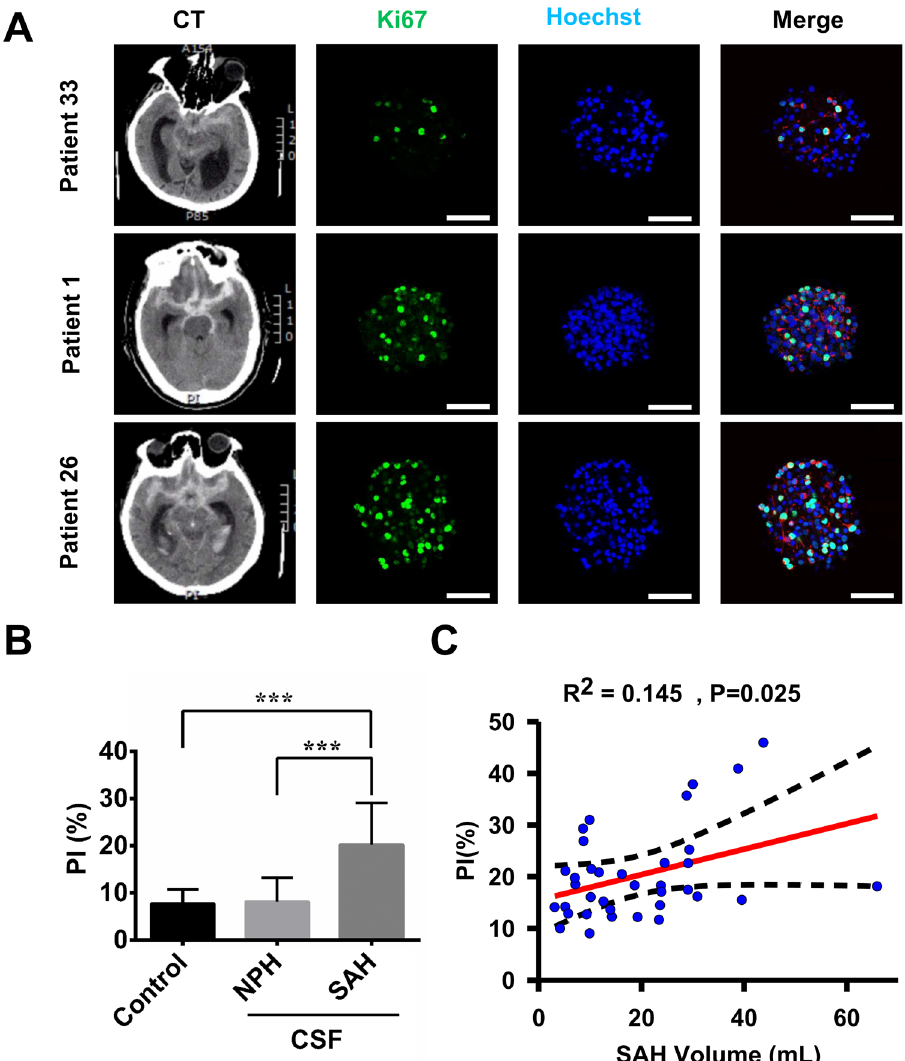
Figure 3. The effects of CSF samples collected at post-SAH day 5 on NSC proliferation. ( A ) The cultured NSCs without treatment (control) or treated with CSF samples collected from patients with NPH or SAH were double immunostained with anti-Ki-67 (green) and anti-nestin (red) antibodies with Hoechst 33258 (blue) staining. Initial head CT scan shows SAH in three patients (Patients 33, 1, and 26) with different severity (SAH volume of 9.9, 24.5, and 43.8 mL, respectively). The PI values in these three patients were 9.0, 22.6, and 45.9, respectively. Scale bar = 50 μ m. ( B ) Comparison of the PI between different groups is shown, including control (n = 6), NPH (n = 6), and SAH (n = 36) groups. *** p < 0.001. ( C ) Correlation between the SAH volume and PI in 36 patients with SAH. p = 0.025 using linear regression analysis. The red solid line is the regression line and dashed lines are 95% confidence